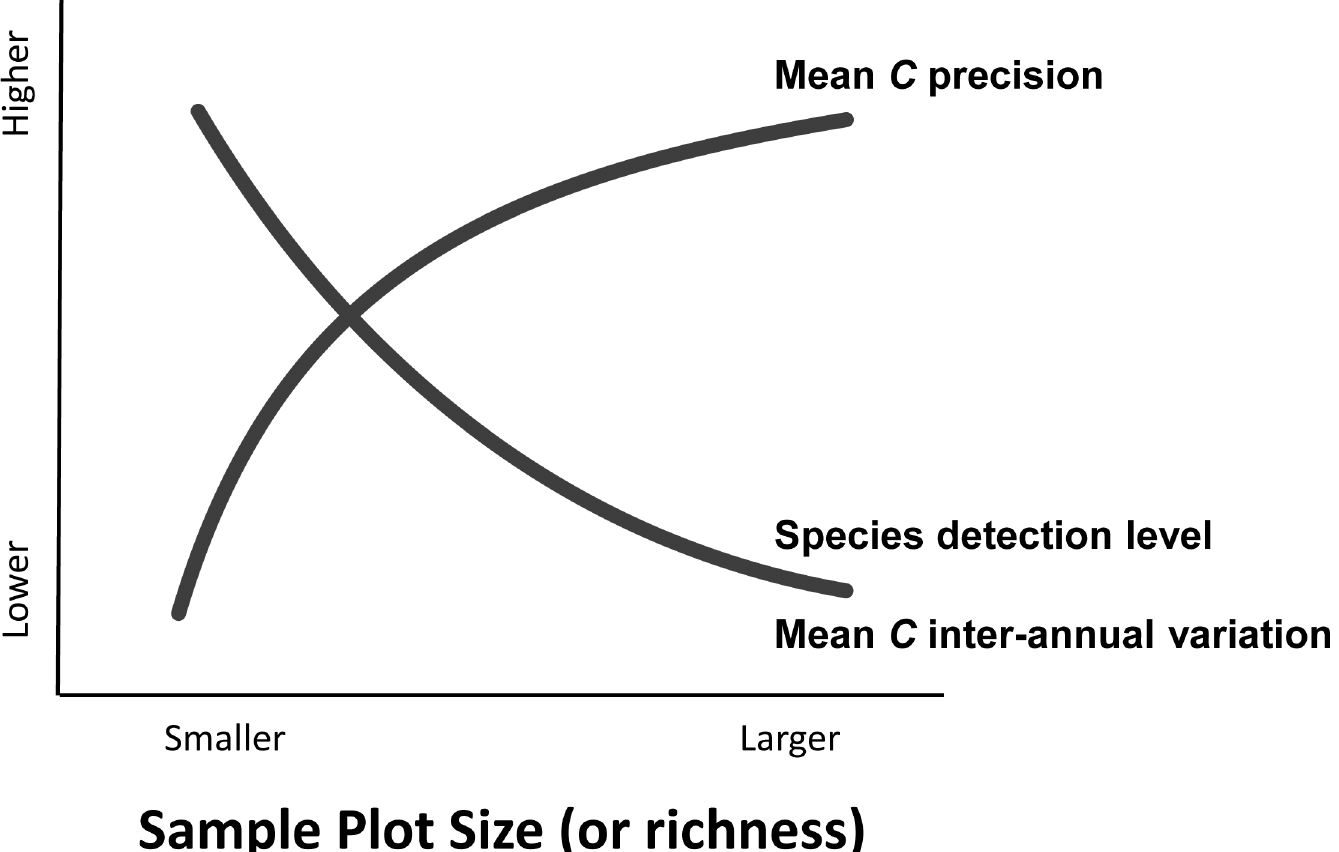
Fig 5. Generalized relationship between common sampling/analysis considerations and Mean C . Plot richness can be important to consider when sampling/comparing habitats with different diversity levels.